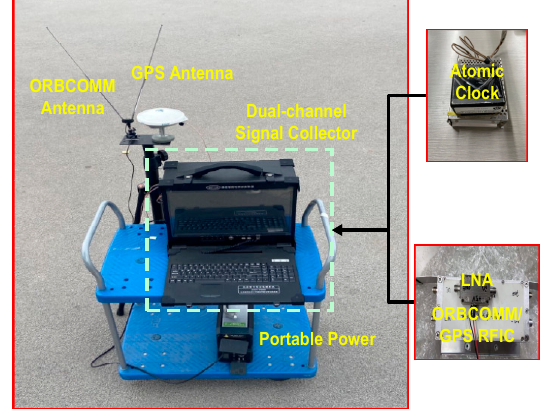
Figure 5. Hardware device setup.